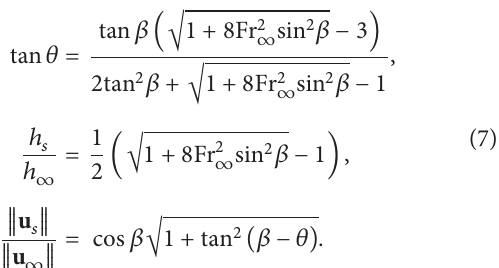
induced by means of an interaction between a